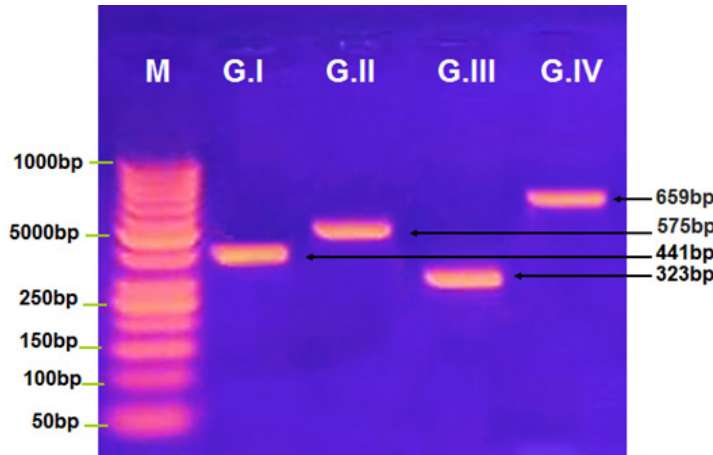
Fig. 2. Shows amplification of agr locus nucleotide polymorphism. Ladder is